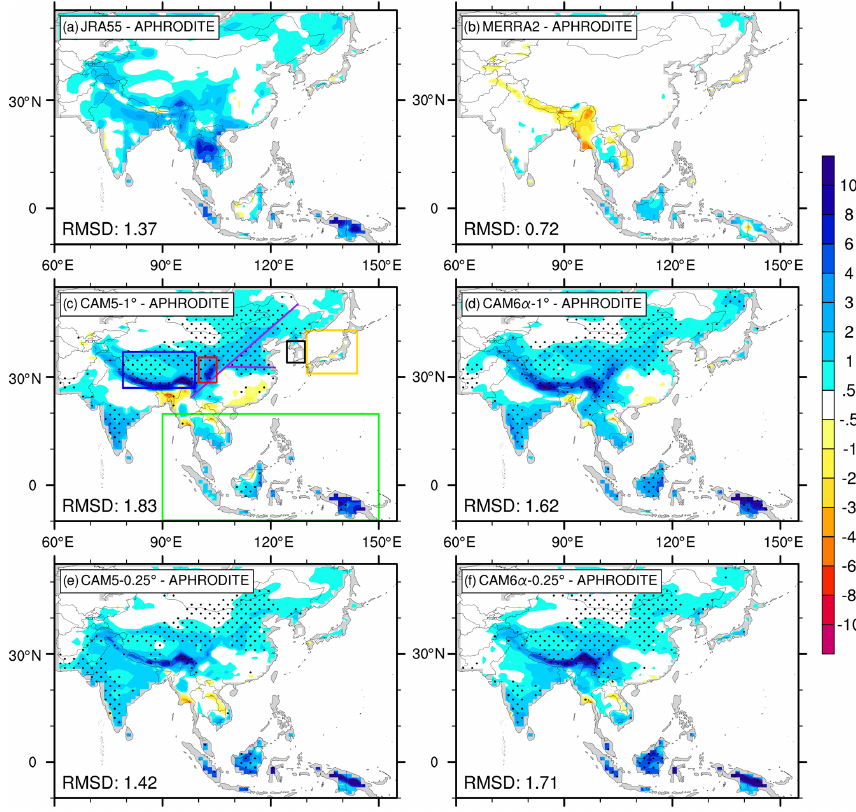
Figure 2. The difference of 1980–2004 annual mean precipitation (mmd − 1 ) between APHRODITE and (a) JRA55, (b) MERRA2, (c) CAM5-1 ◦ , (d) CAM6 α -1 ◦ , (e) CAM5-0.25 ◦ and (f) CAM6 α -0.25 ◦ . The values at the lower left of each panel indicate the root mean square difference (RMSD) relative to APHRODITE. Grid points in panels (c–f) are stippled when the absolute value of the difference between the model and APHRODITE is larger than that between JRA55 and APHRODITE. All the data were interpolated to 1 ◦ resolution. The boxes with different colors in Fig. 2c are as follows. (1) Tibet (blue box): 27–37 ◦ N, 79–99 ◦ E; (2) southwestern China (red box): 28.5–35.5 ◦ N, 100–105 ◦ E; (3) Korea (black box): 34–40 ◦ N, 124.5–129.5 ◦ E; (4) Japan (gold box): 31–43 ◦ N, 130–144 ◦ E; (5) the Maritime Continent (green box): 9.75 ◦ S–19.75 ◦ N, 90–150 ◦ E. The India average is entirely within mainland India. Northern China and southern China are also defined in Fig. 2c: northern China is north of Qin Mountain and the Huai River at 32.8 ◦ N, and southern China is south of this. The western boundary of northern China and southern China is a straight line called the Hu–Huanyong line between Heihe (50.2 ◦ N, 127.5 ◦ E) and Tengchong (24.5 ◦ N, 98.0 ◦